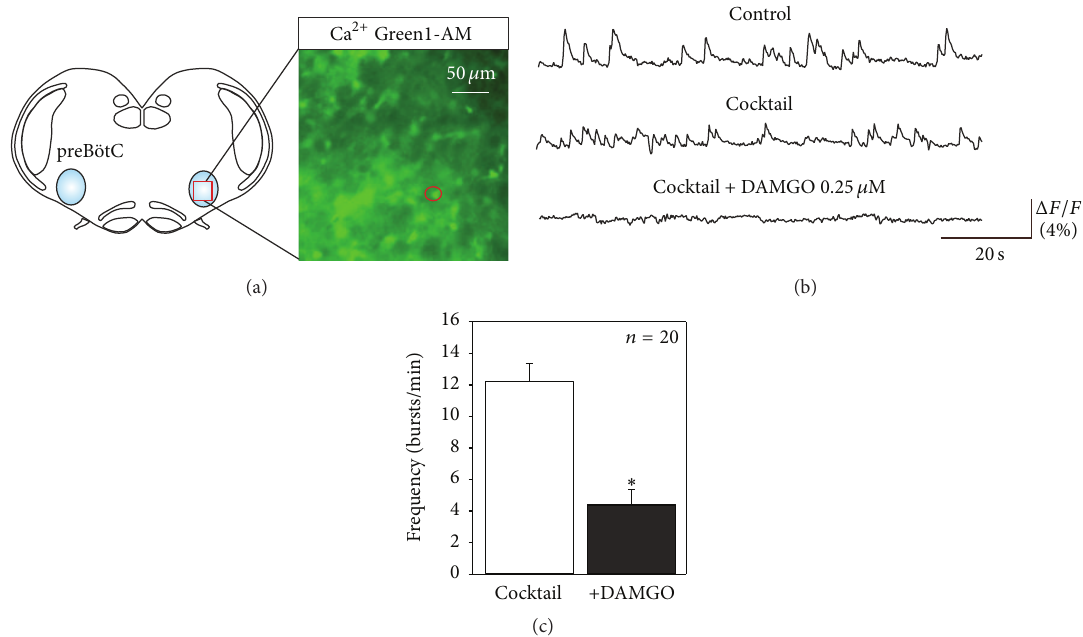
Figure 5: Embryonic respiratory pacemaker neurons are sensitive to DAMGO. (a) Schematic of an embryonic transverse slice showing location of a preB¨otC pacemaker neuron monitored with calcium imaging. (b) Calcium transients recorded from the cell in control conditions (top), after synaptic isolation (middle, cocktail), and in the presence of 0.25 𝜇 M DAMGO (bottom). After isolation, the cell’s rhythmic activity was suppressed in the presence of DAMGO. (c) Pooled data showing mean frequency ( ± SEM) of activity expressed by 20 pacemaker neurons in cocktail (white bar) and under the presence of DAMGO (black bar). Asterisk: 𝑃 < 0.05 . temperature was increased steadily from 28 ∘ C up to 32 ∘ C, rhythm was measured in both conditions (Figure